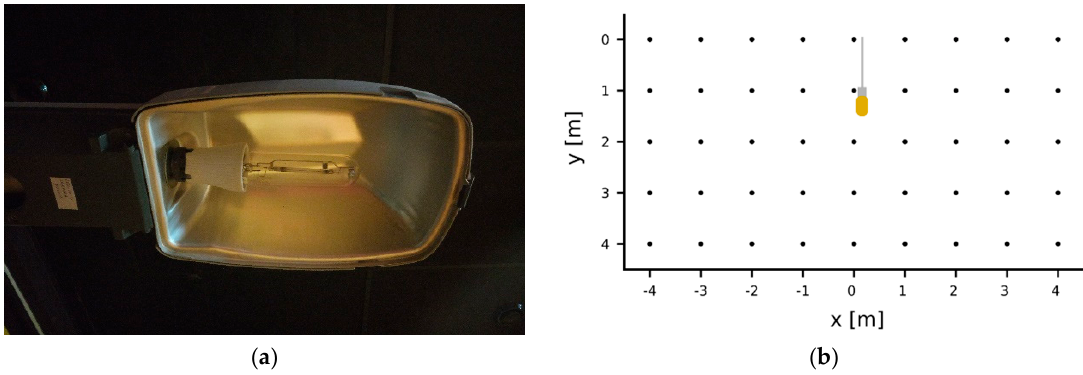
Figure 3 . Experimental system details: ( a ) luminaire; and ( b ) grid of 9 × 5 on the ground plane where the luminance was measured.